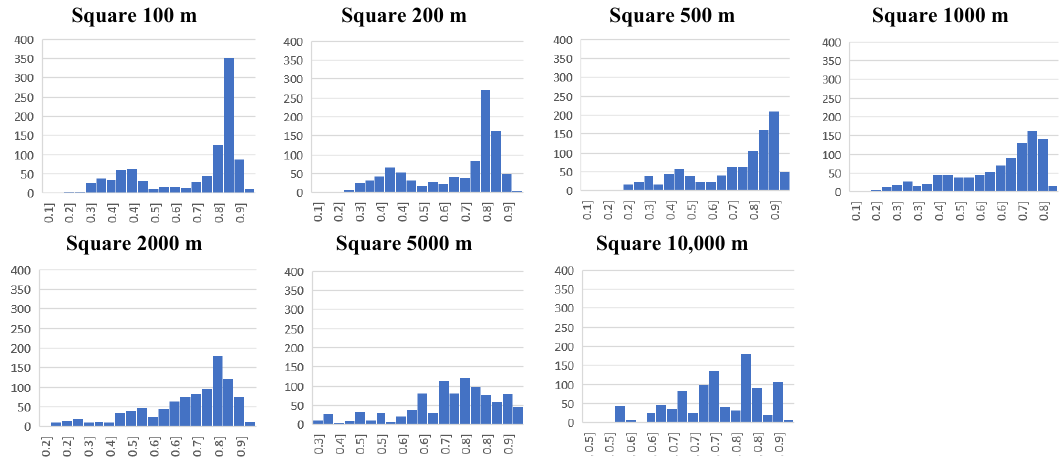
Figure 10. Histogram of the distribution of indices of passability for the analysed cell sizes for the 5000 m control point grid (117 points).